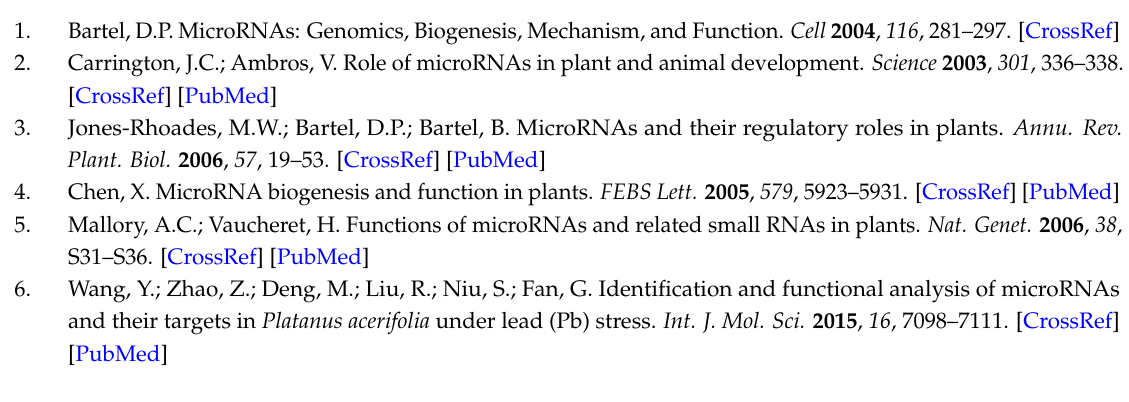
Table S1: qRT-PCR-validated miRNAs and their primers, Table S2: Conserved miRNAs identified in Ulmus pumila L., Table S3: Novel miRNAs identified in Ulmus pumila L., Table S4: Identification of putative targets for Ulmus pumila L.